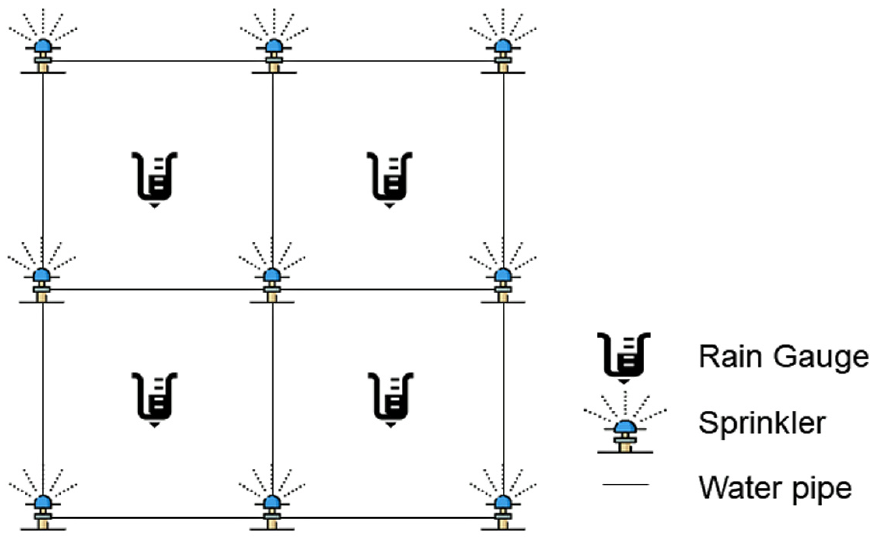
Figure 1. The layout of sprinklers and rain gauges on experimental plots (4 × 4